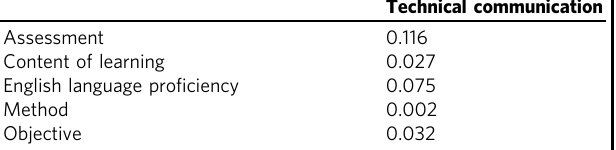
Table 16 Effect size ( f 2 ) assessment for the structural model.